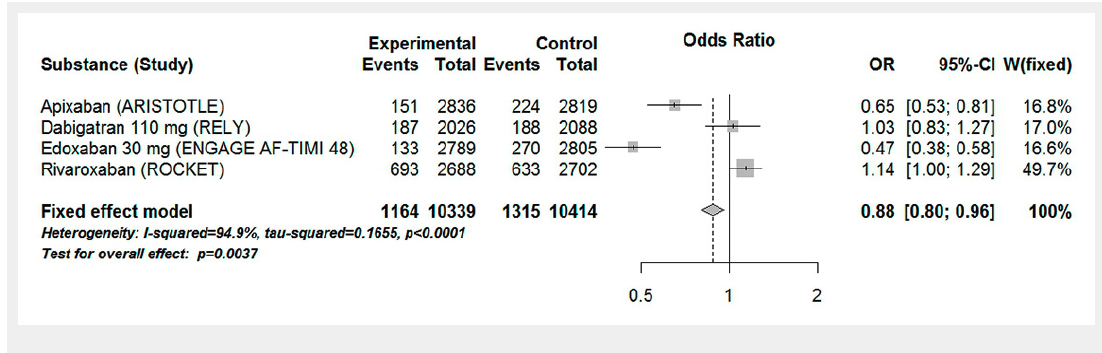
Figure 6 Forest plot of composite major and clinically relevant non-major bleeding in patients with atrial fibrillation aged 75 years or over for analysis including low dose dabigatran and edoxaban. CI = confidence interval; experimental = direct oral anticoagulants; control = vitamin K antagonists